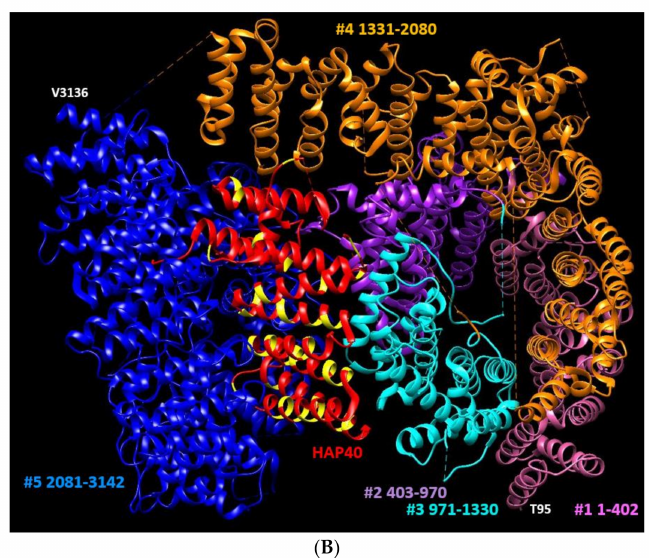
Figure 1. The structure of huntingtin (HTT) in complex with HAP40. From PDB:6X9O. Using disordered regions as borders, we defined the following regions of HTT: #1, 1–402 (pink); #2, 403–970 (violet); #3, 971–1330 (cyan); #4, 1331–2080 (orange); and #5, 2081–3142 (blue). HAP40 (red) is rich in alanines (yellow). The values of the HTT amino acid coordinates in the PDB record 6X9O are two units lower. The figure was generated using Chimera [13]. The views in ( A , B ) are rotated 90